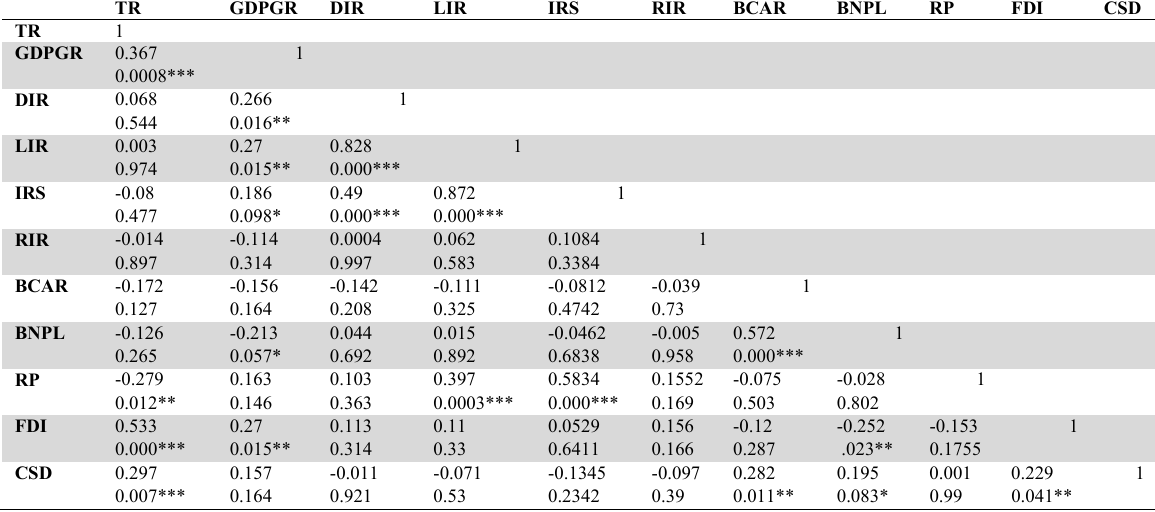
Correlation matrix